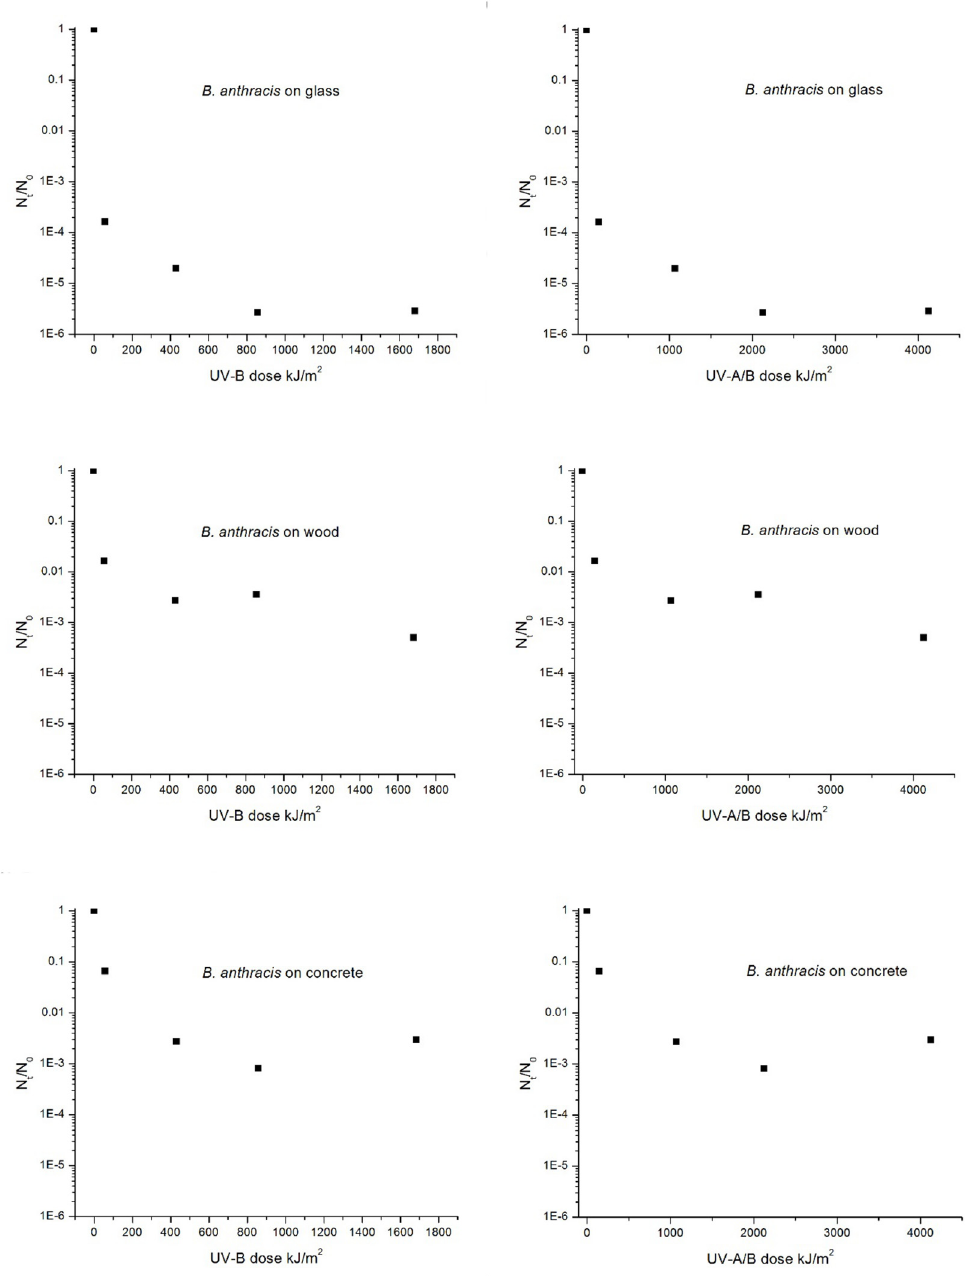
Fig 6. Decay of B . anthracis spores as a function of UV dose (kJ/m 2 ), species, and material. Dose values are shown for UV-B and UV-A/B and were determined based on measured UV intensities and exposure